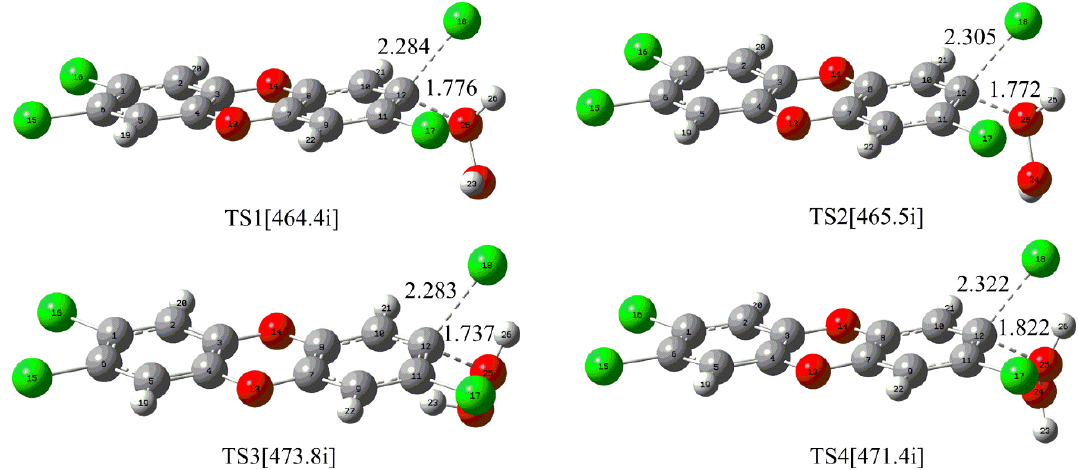
Figure 1. Calculated transition states for the direct nucleophilic attack of neutral H 2 O 2 on TCDD. The selected distances are given in Å and the data in square brackets refer to the imaginary frequency of the transition state, which is true for the remaining figures.